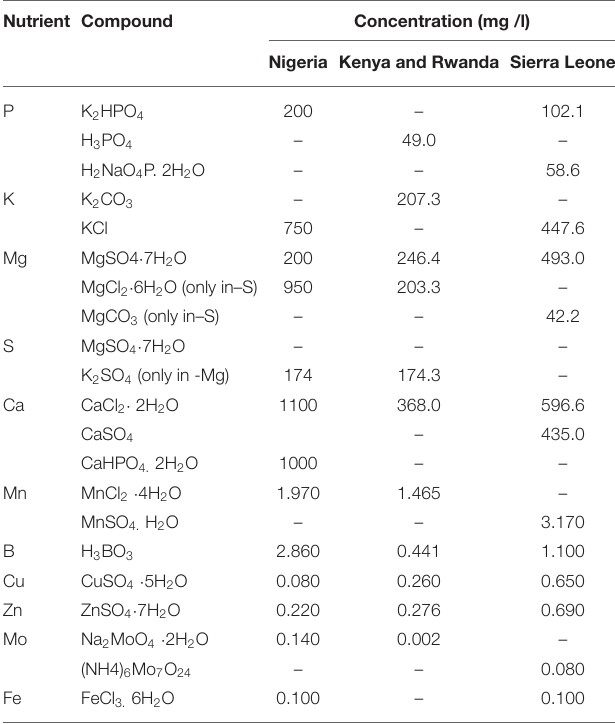
TABLE 3 | Salt form and concentrations used to prepare the nitrogen-free nutrient solutions before application to the plants. Nutrient Compound